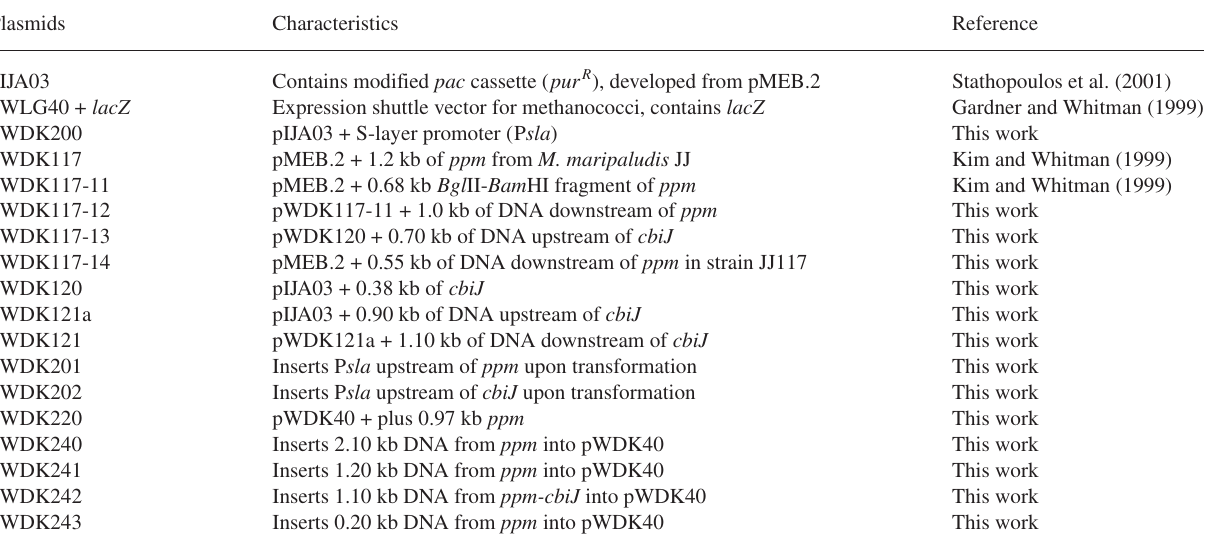
Table 1. Plasmids used in this study. Plasmids Characteristics